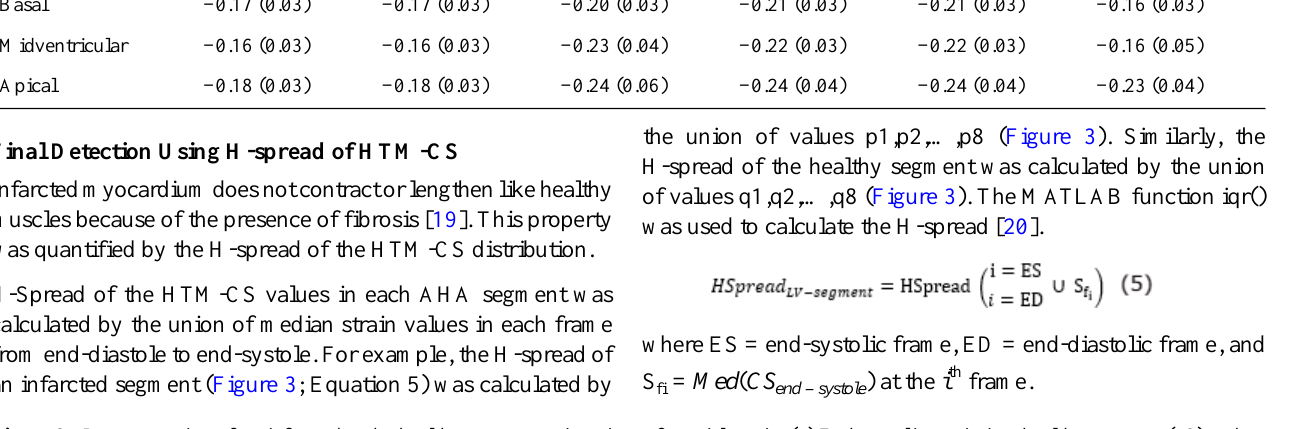
Inferior strain,